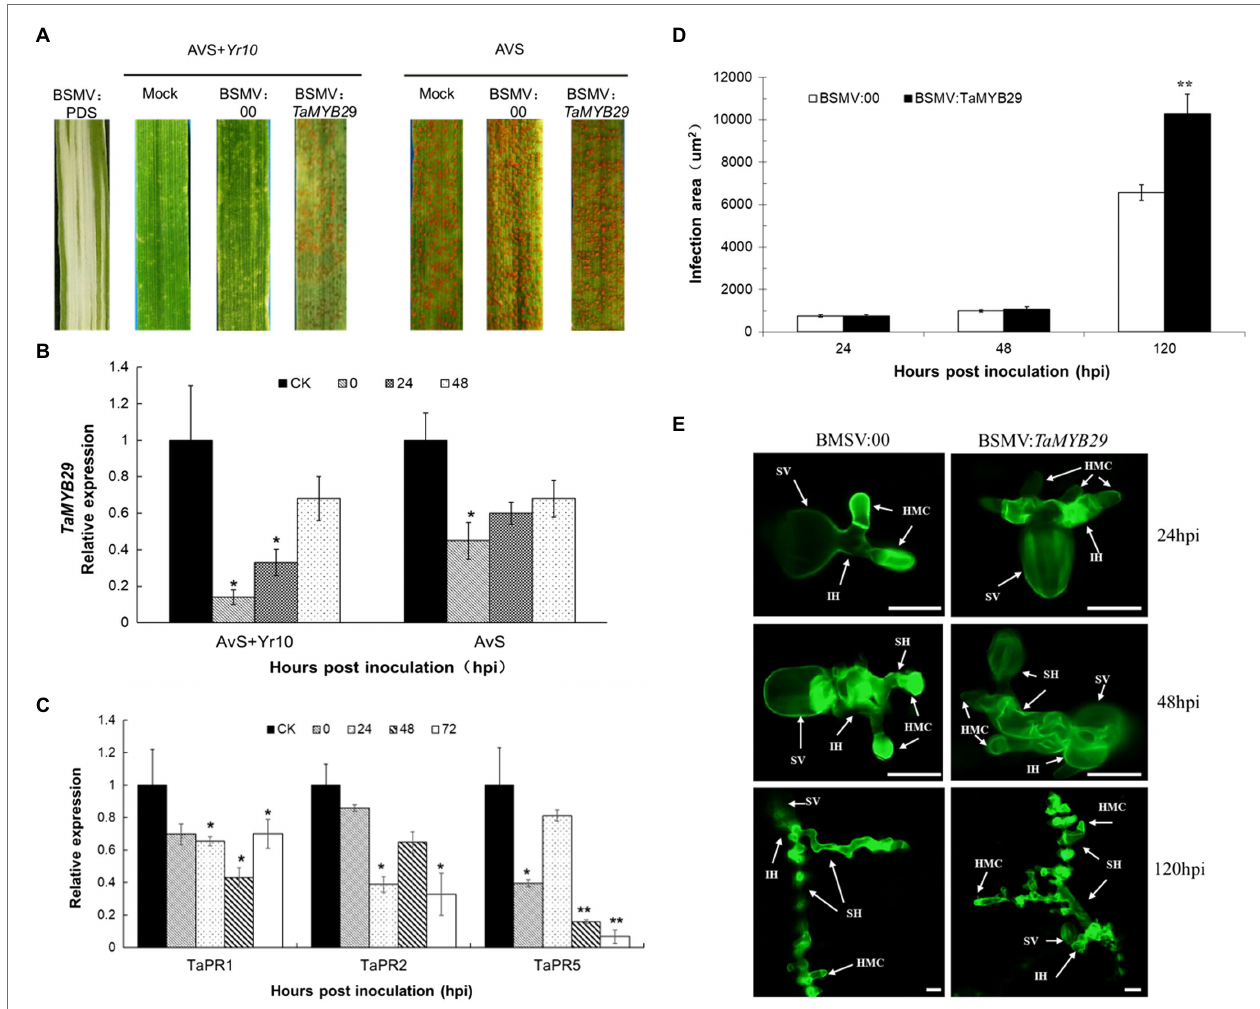
FIGURE 7 | Functional analysis of the TaMYB29 gene by the BSMV-VIGS assay. (A) Infection type of AvS and AvS+ Yr10 wheat leaves to CYR32 after inoculated with BSMV:00 or BSMV: TaMYB29 . Stripe rust was inoculated 9 days post-BSMV inoculation. Pictures were taken 15 days post-rust inoculation. Mock: wheat leaves inoculated with FES buffer. BSMV:00 means only the BSMV genome; BSMV: TaMYB29 means a 183-bp fragment of TaMYB29 was inserted into the BSMV: γ genome. Photobleaching was evident on the leaves infected with BSMV: PDS but not on the mock-inoculated leaves. (B) Transcriptional level of TaMYB29 in AvS and AvS+ Yr10 during the course of Pst infection at 0, 24, and 48 hpi. CK: wheat leaves treated with BSMV:00. (C) Transcriptional level of pathogenesis-related gene TaPR1 , TaPR2, and TaPR5 in TaMYB29 silenced AvS+ Yr10 wheat leaves after inoculated with Pst . Leaves were sampled at 0, 24 48, and 72 hpi. Three independent biological replications were performed. Error bars represent standard deviation among three biological replicates. Student’s t -tests were used for the statistical analyses and the asterisks ( ∗ ) and ( ∗∗ ) indicate a significant difference between that time point and 0 hpi with a value of p < 0.05 and 0.01, respectively. (D,E) Infection area (D) and hyphae development of Pst (E) in TaMYB29 knockdown AvS+ Yr10 wheat leaves after infected with CYR32. Wheat leaves were sampled at 24, 48, and 120 hpi and observed microscopically after stained with WGA. SV, substomatal vesicle; IH, initial hyphae; HMC, haustorial mother cell; and SH, secondary hyphae. Bars = 20 μ